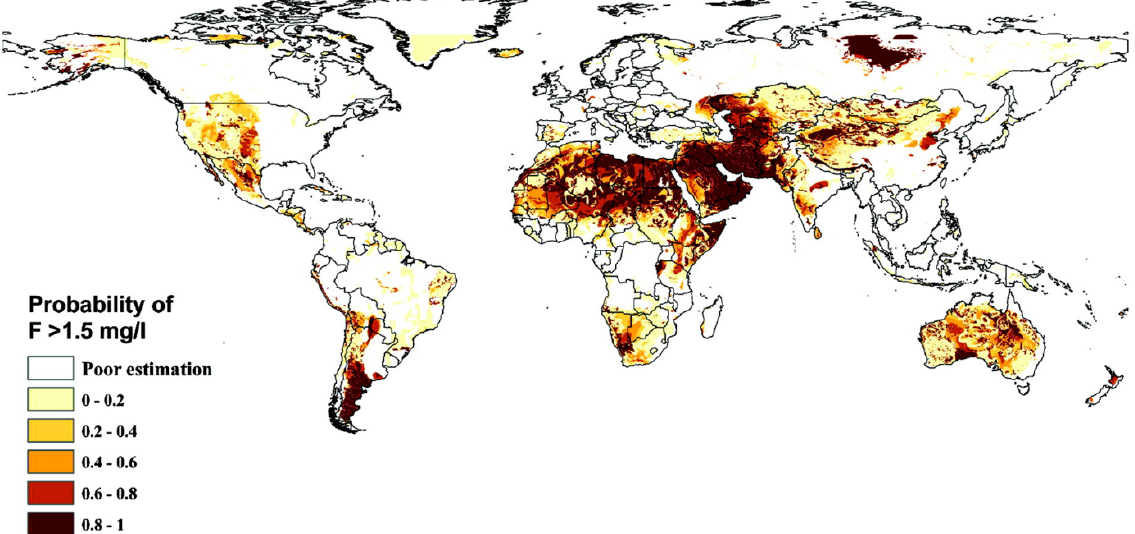
Figure 1. Predicted fluoride concentration in groundwater worldwide as per World Health Organization (WHO) permissible limit for drinking purposes. Adapted from Amini et al. [25].